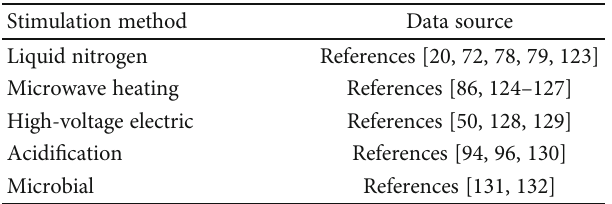
Table 4: Data source of laboratory-scale stimulation e ff